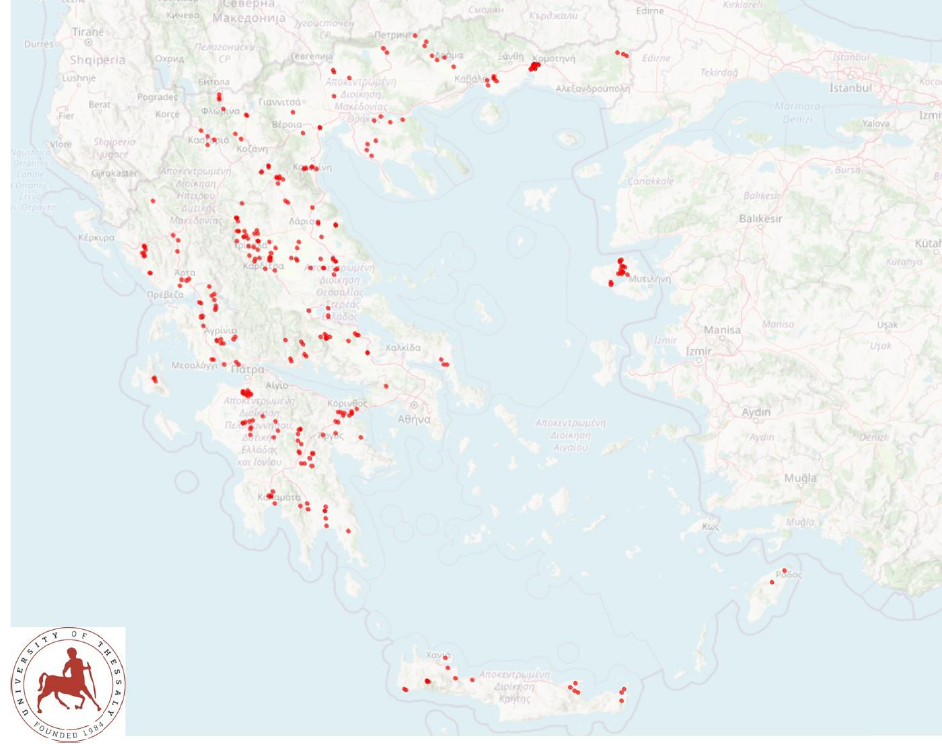
Figure 1. The location of 325 sheep flocks around Greece, which were visited for faecal sampling.